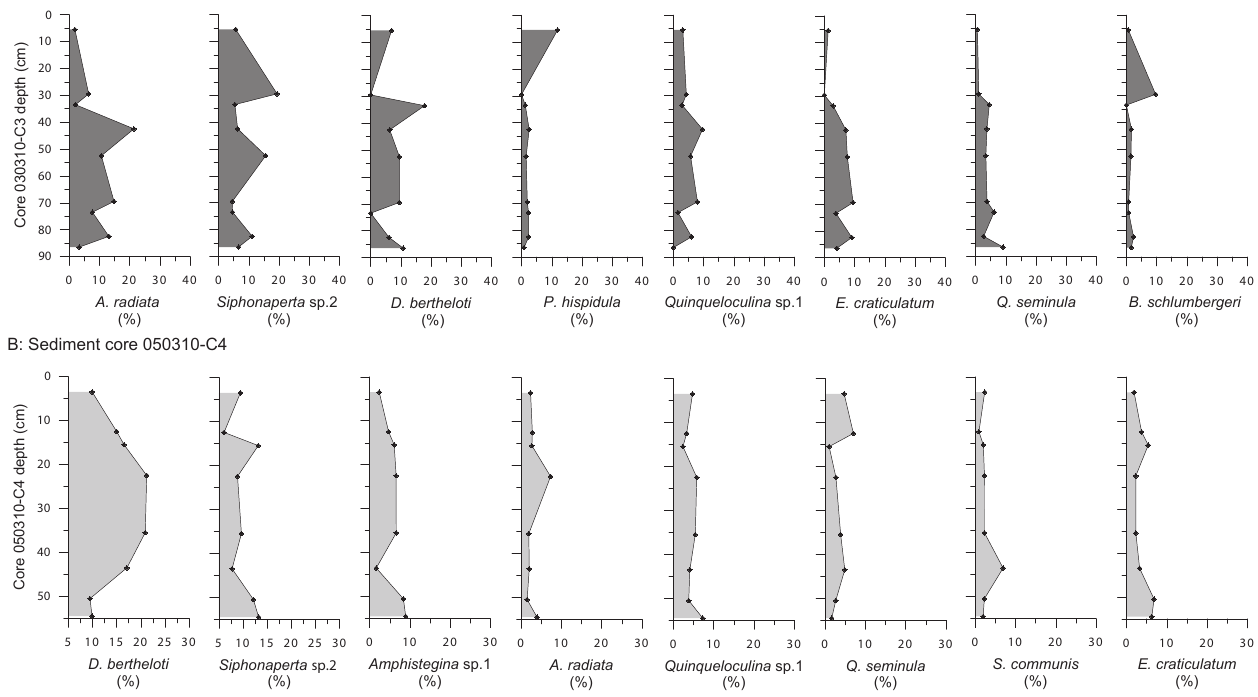
Fig. 6. Distribution of the most abundant fossil benthic foraminifera in sediment cores 030310-C3 (A) and 050310-C4 (B) . Only species with a relative abundance of > 5% on the fossil assemblages in the sediment cores are presented.